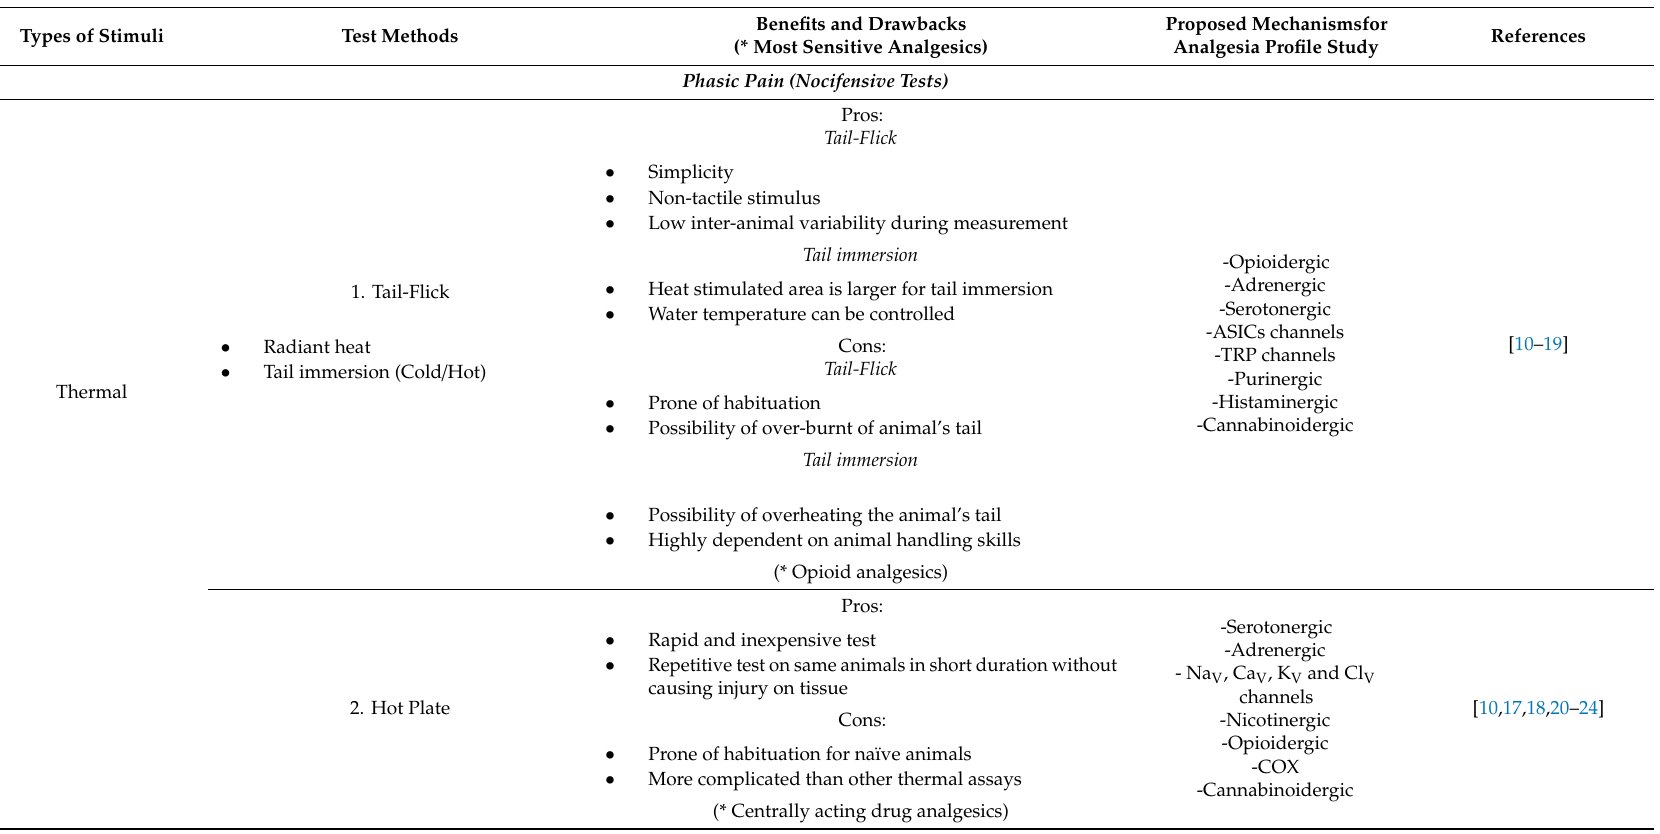
Table 1. The summary of di ff erent animal “pain-like” behavioral study methods, benefits, drawbacks and the respective proposed mechanisms of action for analgesic profile